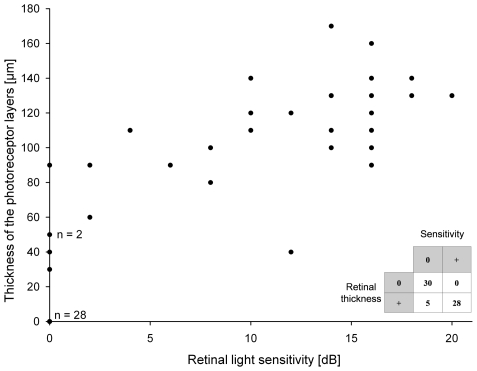
Correlation of retinal light sensitivity (in dB, x-axis) and outer retinal thickness (in µm; y-axis).The cross table compares positive sensitivity and thickness values (i.e. detectable outer retina on SD-OCT images and measurable light sensitivity) with those having a value of zero. There was a significant relationship between the outer retinal thickness and retinal sensitivity (p<0.001; two-sided Fisher exact test of significance). A clustering of data at zero (n = 28) implicates that a complete loss of the outer nuclear layer was associated with an absolute scotoma, i.e. a complete loss of retinal light sensitivity. When omitting this subset in a sub-analysis, outer retinal thickness and retinal sensitivity still showed a significant correlation (r = 0.66; p<0.001; Spearman-Rho; positive scatter plot).